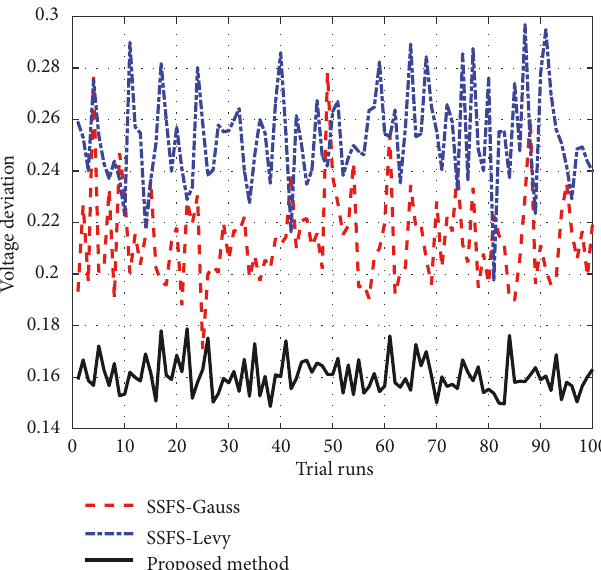
Figure 11: Comparisons of 100 runs for voltage deviation objective of IEEE 118-bus system obtained by three methods.